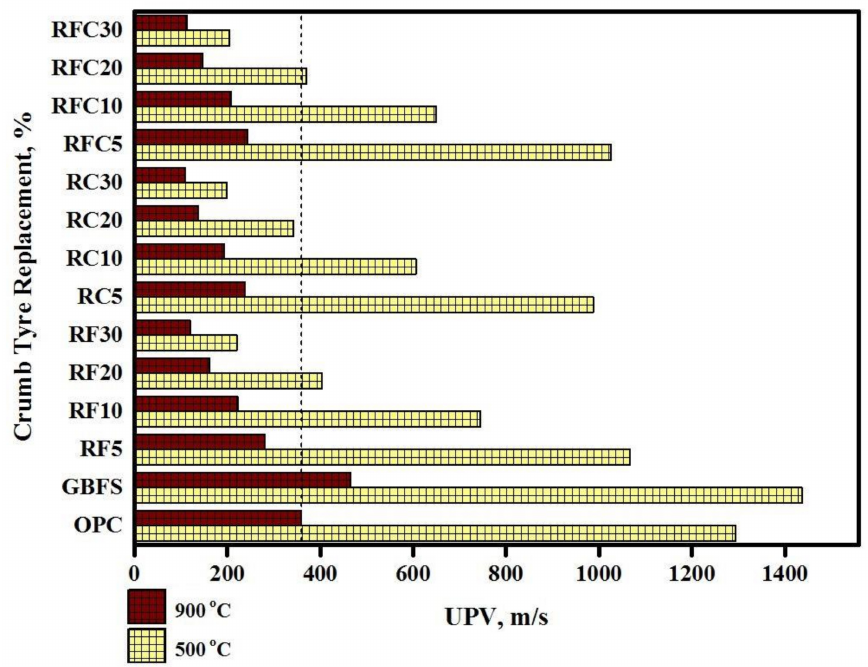
Figure 11. The UPV readings of the modified rubberized concrete exposed to the elevated temperatures. Figure 12 illustrates the XRD patterns of OPC based, GBFS, and rubberized modi- fied concrete after exposed to 500 and 800 ◦ C elevated temperature. The XRD analysis demonstrated that the concretes composition was significantly affected by the fire or high temperatures. In all the above-mentioned specimens, the ettringite and gypsum were produced when subjected to 500 ◦ C. Furthermore, the C-S-H and SiO 2 peak intensities were significantly weaker for the heated treated mixes than those without elevated temper- ature exposure. Specimens exposed to heat measuring at 900 ◦ C showed comparatively lower XRD peaks compared to specimens exposed to 500 ◦ C heat, indicating that concrete decomposed at a higher rate with higher temperatures. However, the peaks at 18, 31, 37, 38, 41 ◦ and 48 ◦ for both OPC and GBFS specimens without heating were broader than those exposed to 500 ◦ C. The breakdown which occurs within hydration products at 900 ◦ C had a notable effect on the interface performance. Additionally, the dehydroxylation of calcium hydroxide is observable and results in the complete collapse of the concrete composition, as Ca(OH) 2 was degraded and lost its place in the matrix, lowering the peak intensity of the C-S-H gel. The observed reductions may be due to the Portland dehydroxylation in the ce- ment matrix, which was higher for OPC based concrete. This decay was responsible for the reduced performances and strength losses of the concretes at elevated temperatures. GBFS matrix possesses less calcite that leading to less dehydroxylation of the cement. Therefore, it can be concluded that the GBFS modified concrete provided higher fire